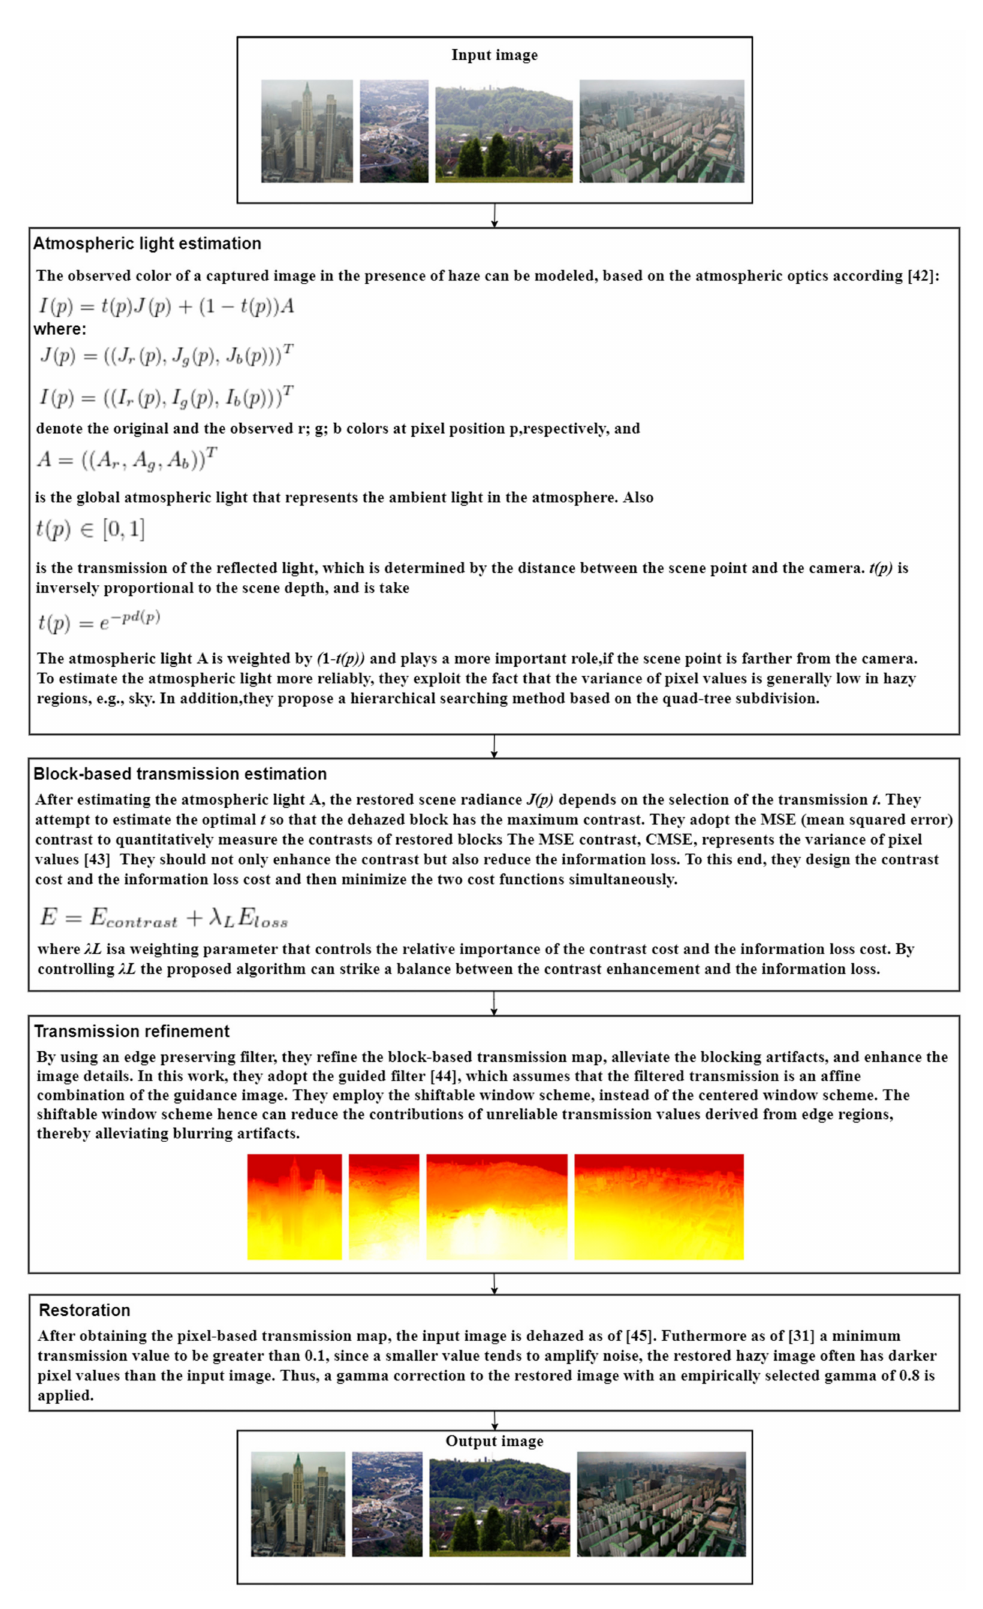
Figure 4. Algorithm description and exemplification of results for the static image dehazing algorithm proposed in